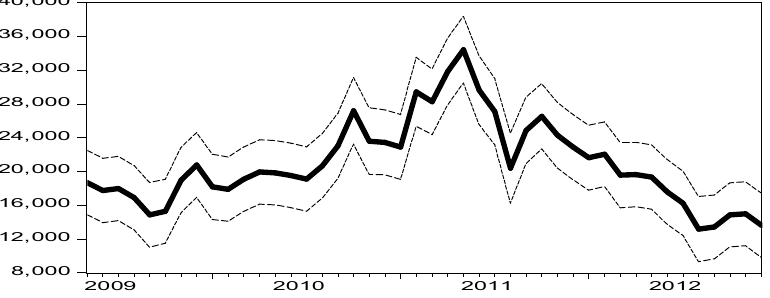
Fig. 8. Machinery price